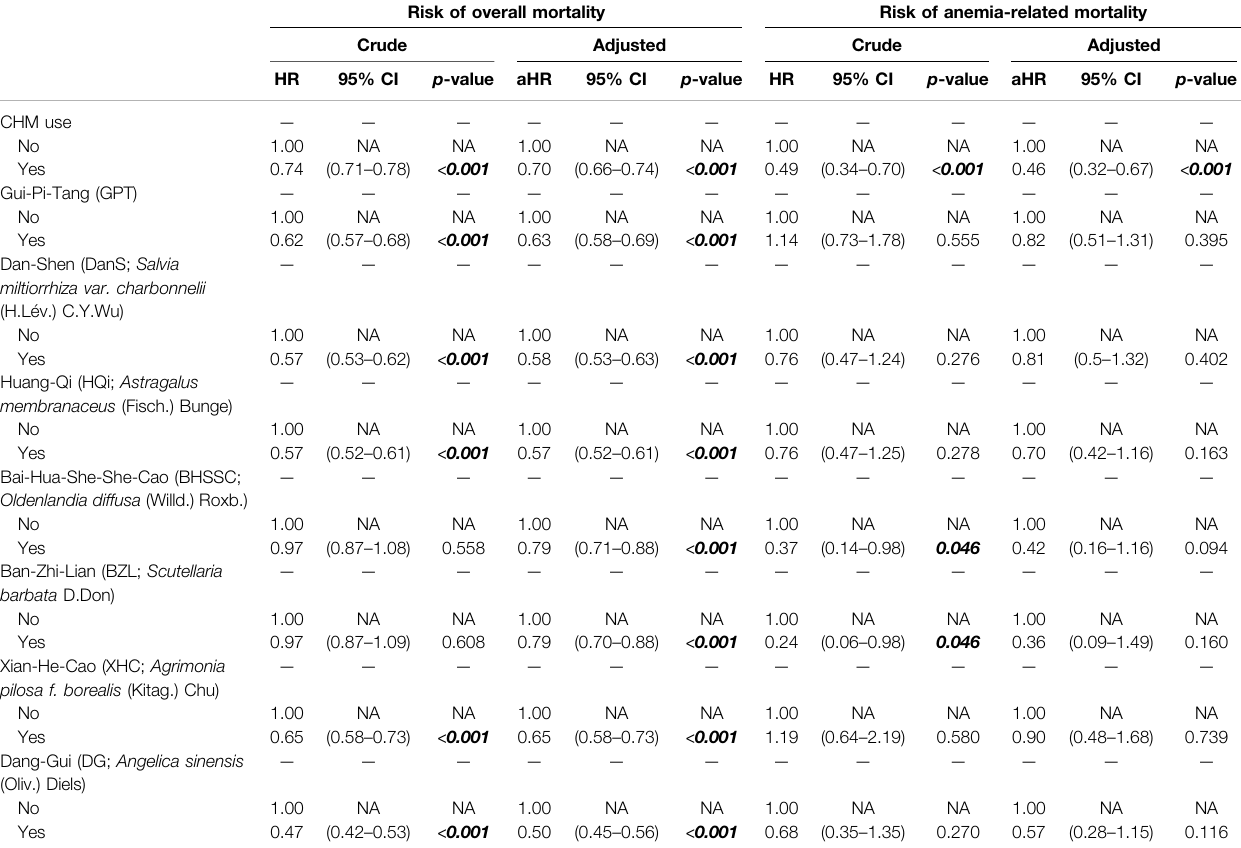
TABLE 5 | Cox proportional hazard models for risk of overall and anemia-related mortalities in patients with aplastic anemia (strati fi ed by herb use). Risk of overall